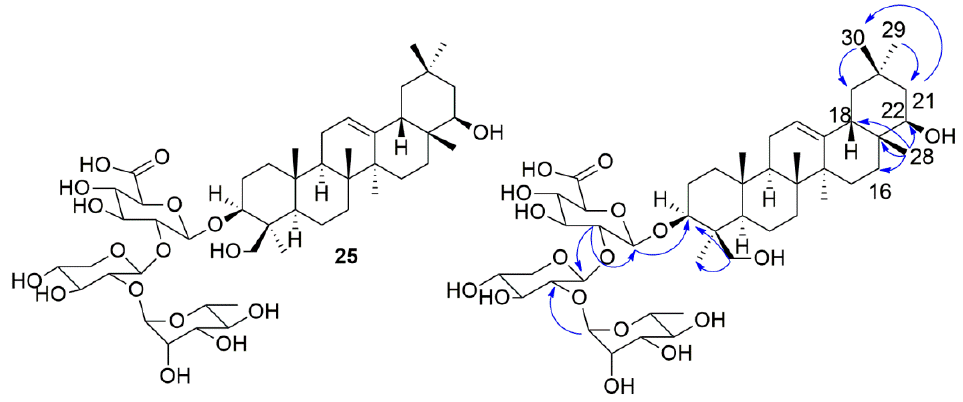
Figure 4. Soyasaponin II ( 25 ) isolated from Z. brasiliensis . ( ) indicates some key HMBC correlations for compound 25 .